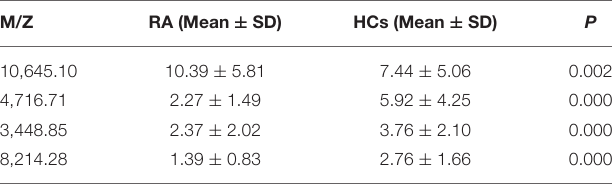
TABLE 2 | Biomarker statistics for RA vs. HCs spectra in the decision tree